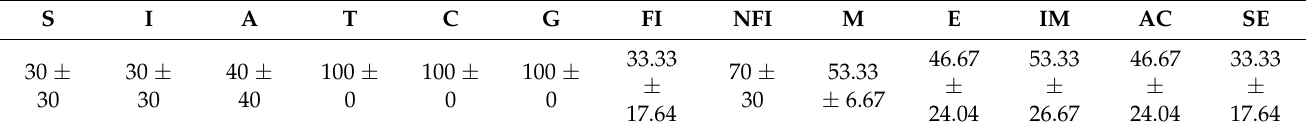
Table 7. Mean values ± SEM of improvement percentage of different parameters of the patients. These parameters were collected from the surveys that were filled out by the families of the patients after 9–10 sessions of equine assisted therapy. Influence of the Equine Assisted Therapy on the Improvement of Different Parameters of the Patients, According to the Surveys.